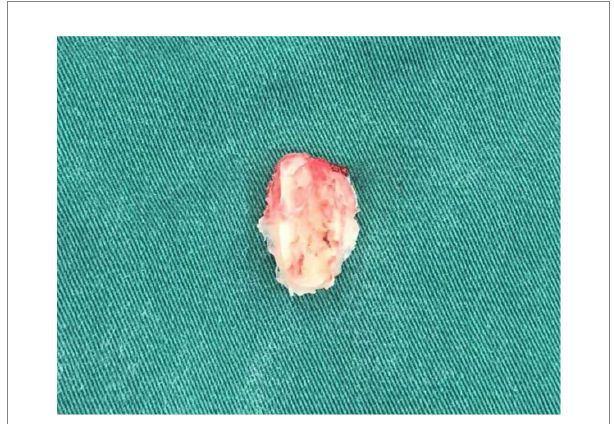
FIGURE 5 Bone flaps before improvements. Adjustment for a larger bone flap was made due to a deeply located sigmoid sinus, the bone window was narrow and the surgical field was restricted.